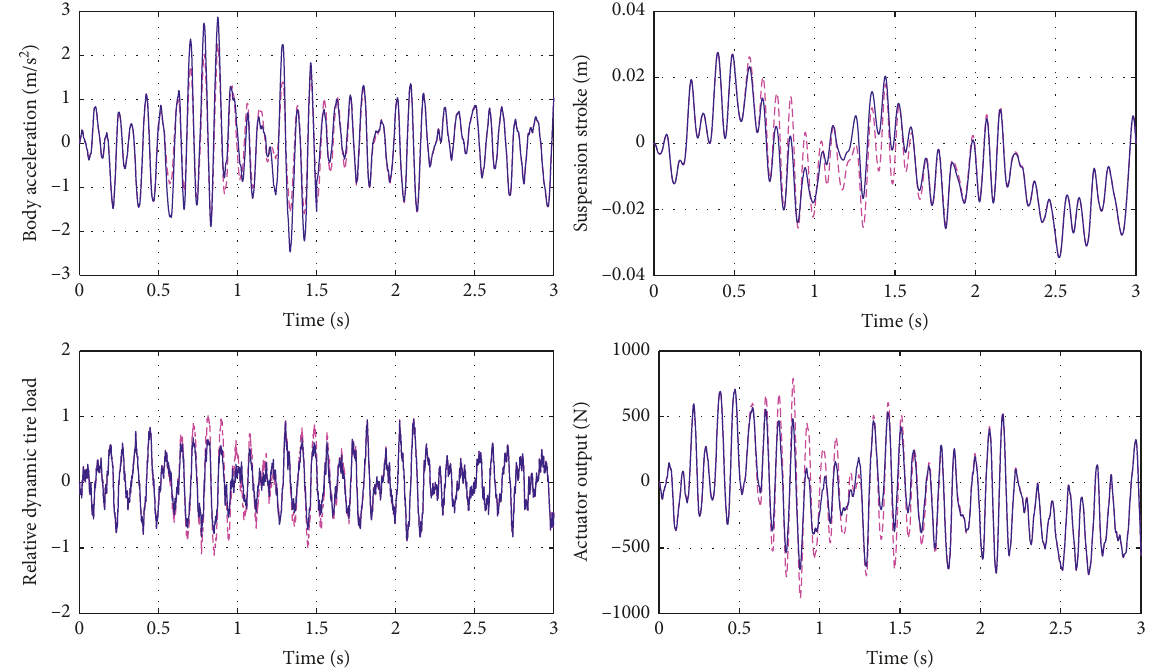
0.5 Figure 8: Active suspension system response with the constant gain change fault (blue solid line) and fault-free (red dotted Table 9: Comparison of RMS values of € z ( m/s 2 ) . s Active (WFTC) Active (FTC) Passive Fault-free Gain change Fault-free